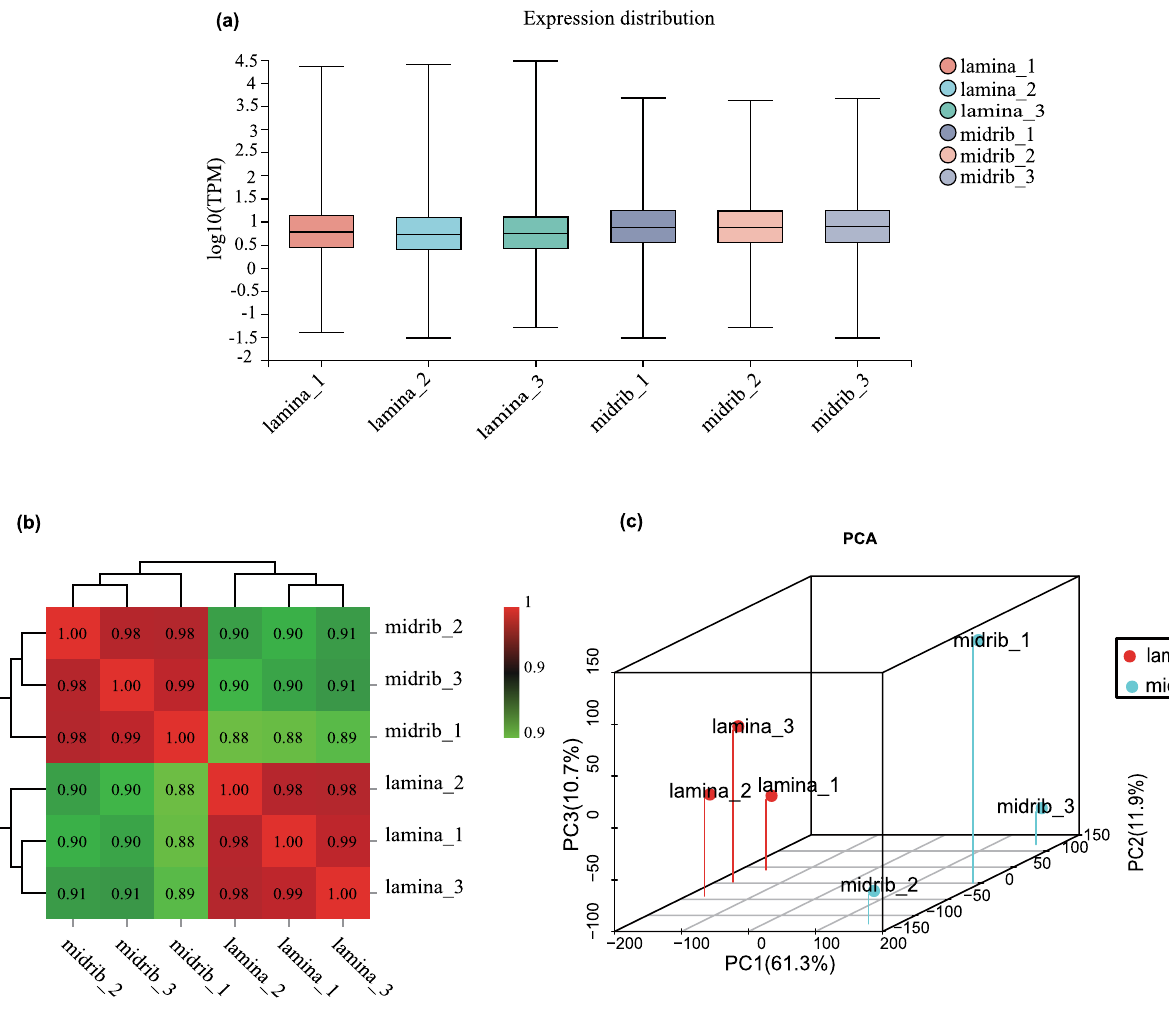
Figure 2. ( a ) Gene expression levels in samples. ( b ) Heatmap of correlation between samples. ( c ) The results of principal component